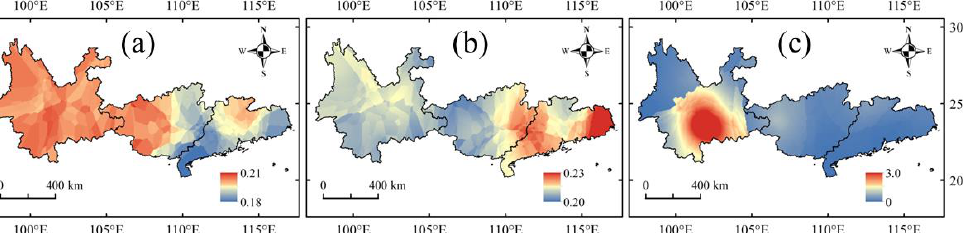
Figure 7. Spatial distribution of the monthly intensities of drought ( a ), flood ( b ), and high temperatures ( c ) during the entire sugarcane growing season in southern China. The intensities were averaged over 1970 – 2020 and displayed here for spatial analysis.